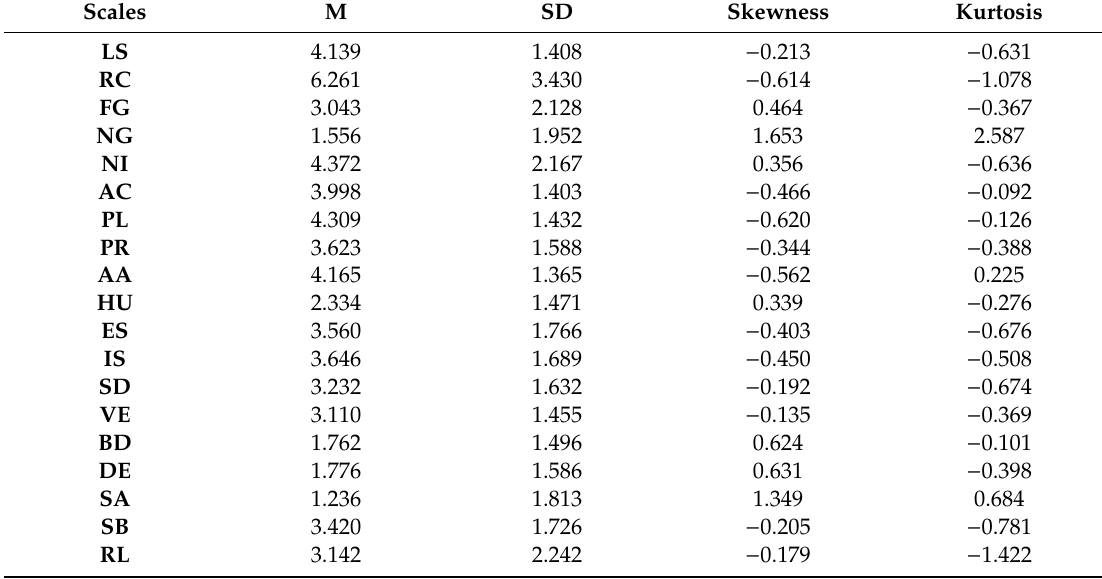
Table 1. Descriptive statistics for the Religious Comfort and Strain Scale (RCSS), the Satisfaction with Life Scale (SWLS), and the Brief Coping Orientation to Problems Experienced (COPE) questionnaire (N =